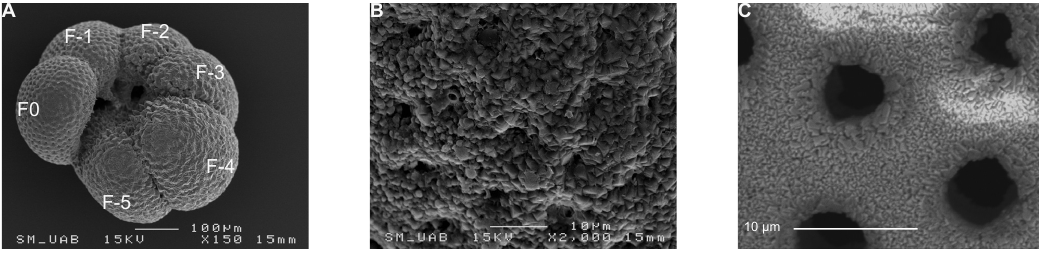
Fig. 2. SEM pictures of N. dutertrei . (A) Overview of entire test from LGM sediment with the naming of the chambers indicated. Note the large crystals on F-2 to F-5. (B) Close-up of the crust morphology of a LGM test. (C) Close-up of the crust morphology of a test from the sediment trap. No cleaning was applied prior to SEM photography.